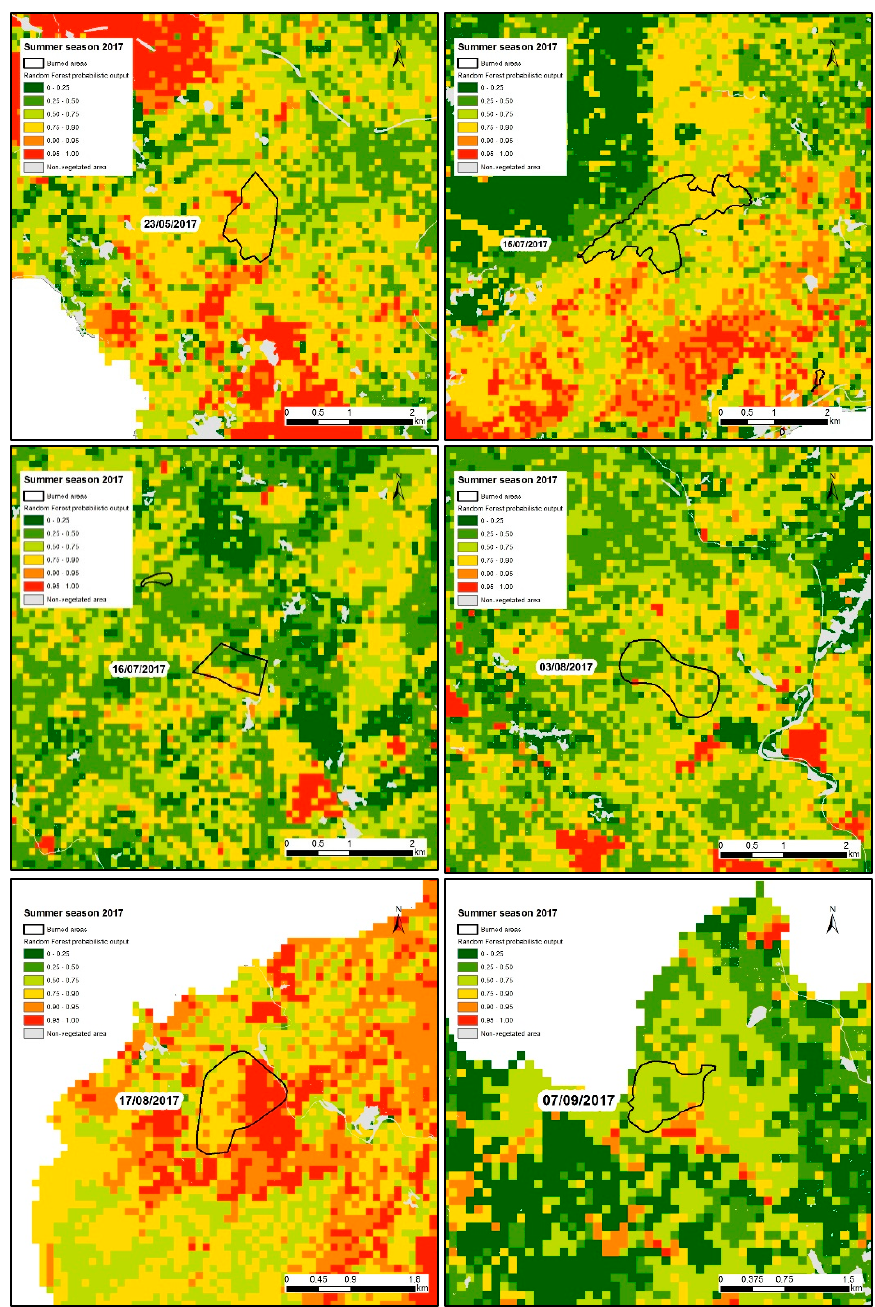
Figure 6. The six largest wildfire occurrences of summer 2017, along with the fire susceptibility map.